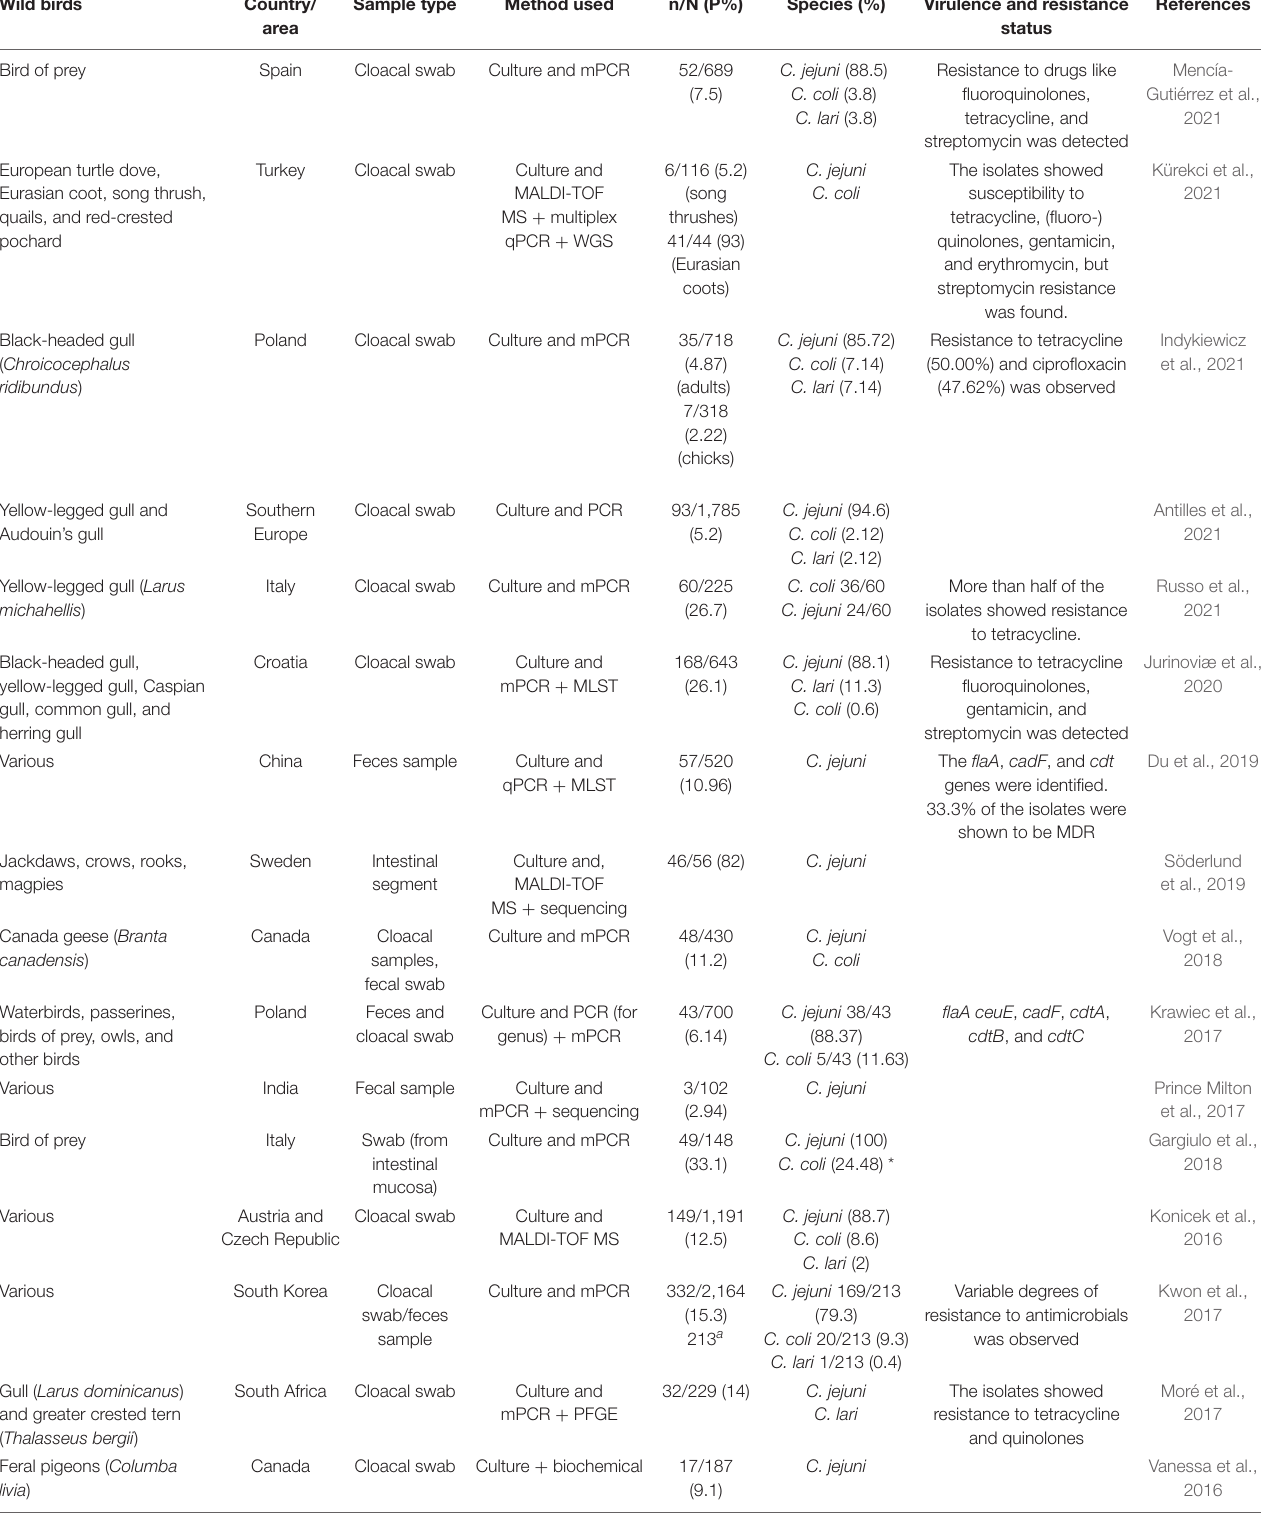
TABLE 1 | Current status and characteristics of Campylobacter spp. isolated from various wild